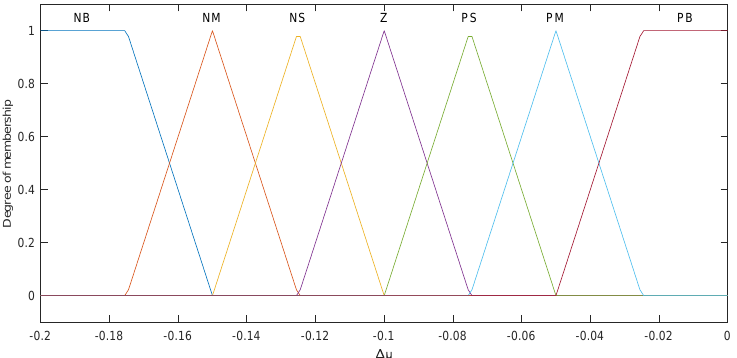
Figure 10. Membership function curve of various ∆ r 1 and ∆ r 2 .